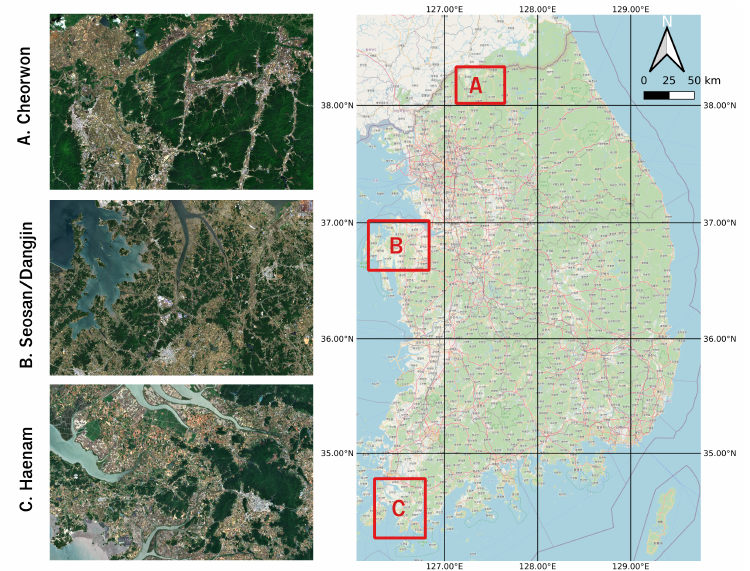
Figure 1. Study area in South Korea—( A ) Cheorwon, ( B ) Seosan-Dangjin and ( C )